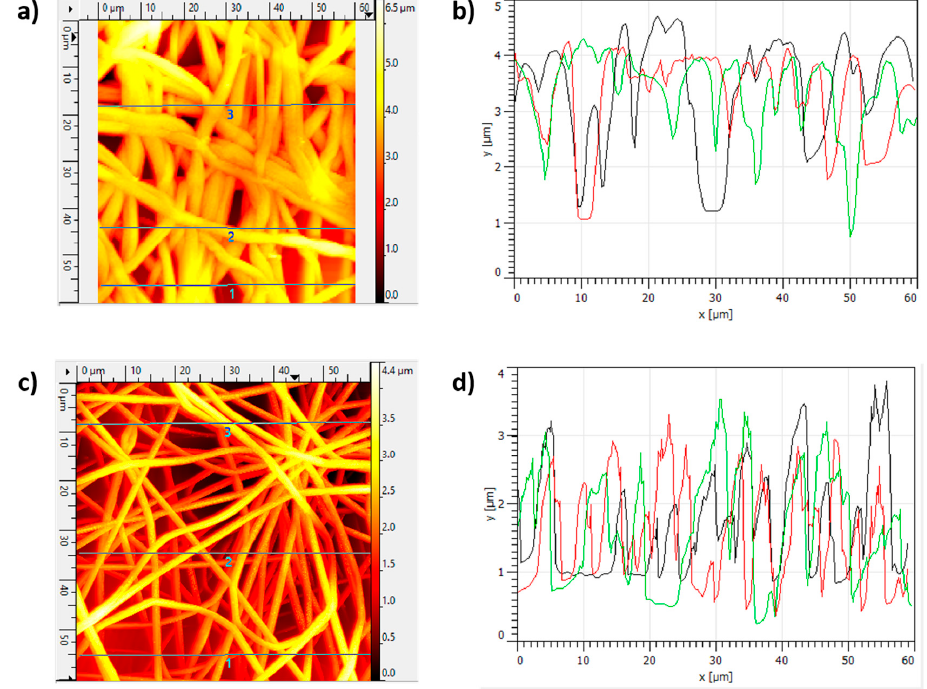
Figure 4. 2D-AFM images for a dimension of 60 × 60 µm 2 of the PS electrospun fibers ( a , b ) and PVC electrospun fibers ( c , d ) with their corresponding profiles.